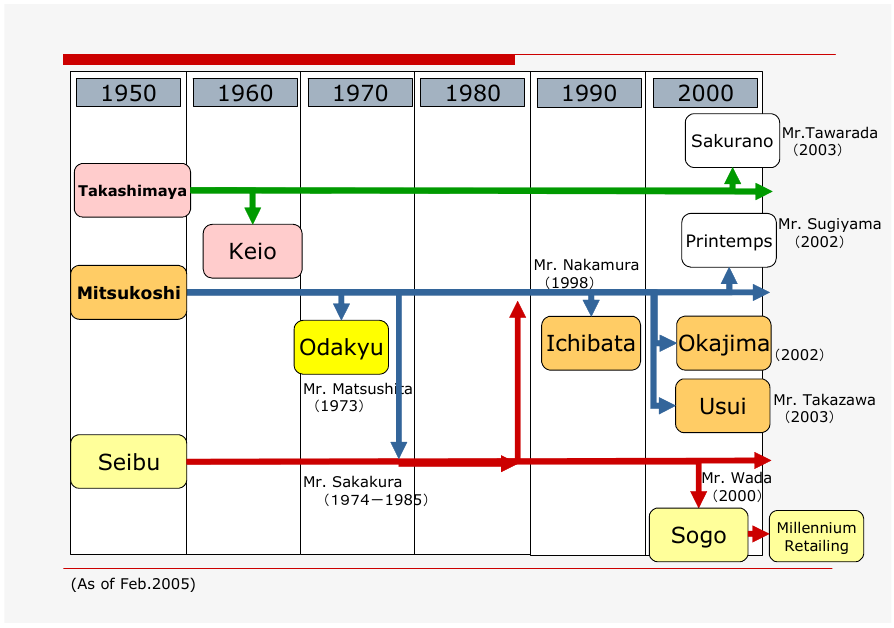
Figure 2. Movement of executive managers between department stores